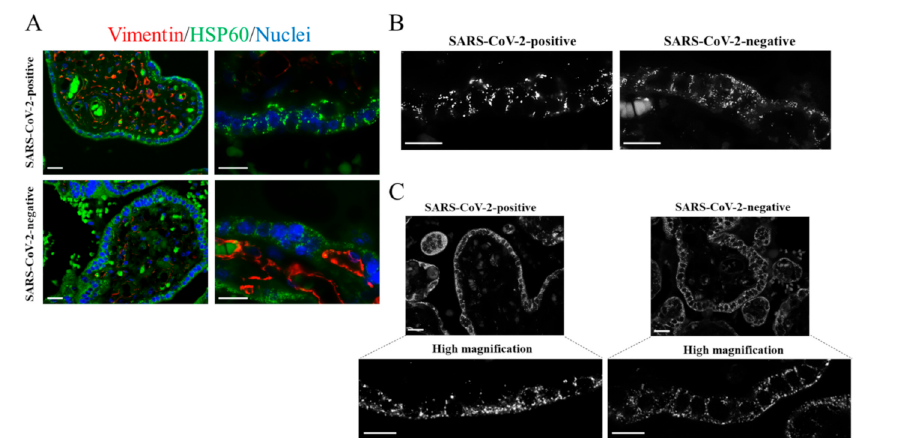
Figure 3. Immunostaining of placental mitochondria. ( A – C ) Representative images of the im- munofluorescence analysis showing mitochondria in placental villi of the SARS-CoV-2 positive and SARS-CoV-2 negative placentas. The images were acquired with 40 × or 100 × oil objectives as indicated. ( A ) Placental sections were immunolabelled with the mitochondrial marker HSP60 (green). Vimentin immunostaining identified endothelial cells of blood vessels (red). Nuclei were labelled with DAPI (blue). ( B ) Representative images visualizing the mitochondrial marker HSP60, acquired with 100 × oil objective, in villous trophoblastic cells. ( C ) Representative images, acquired with 100 × oil objective, showing placental mitochondria immunolabelled with anti-COX IV. Scale bar, 20 µ